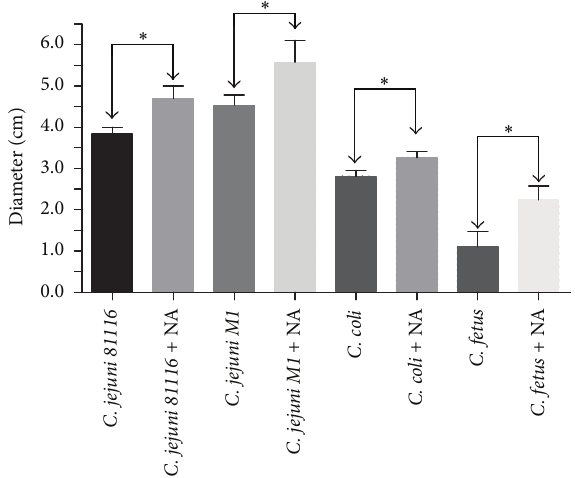
Figure 2: Motility of C. jejuni 81116, C. jejuni M1, C. coli 1669 , and C. fetus fetus at 37 ∘ C. Size of the motility halo after 48 hours in the absence (black) or presence (white) of NA. The diameter of the halo was higher in the presence (white) of NA for all the species of Campylobacter . Star indicates 𝑃 < 0.05. Results are mean of three separate experiments.